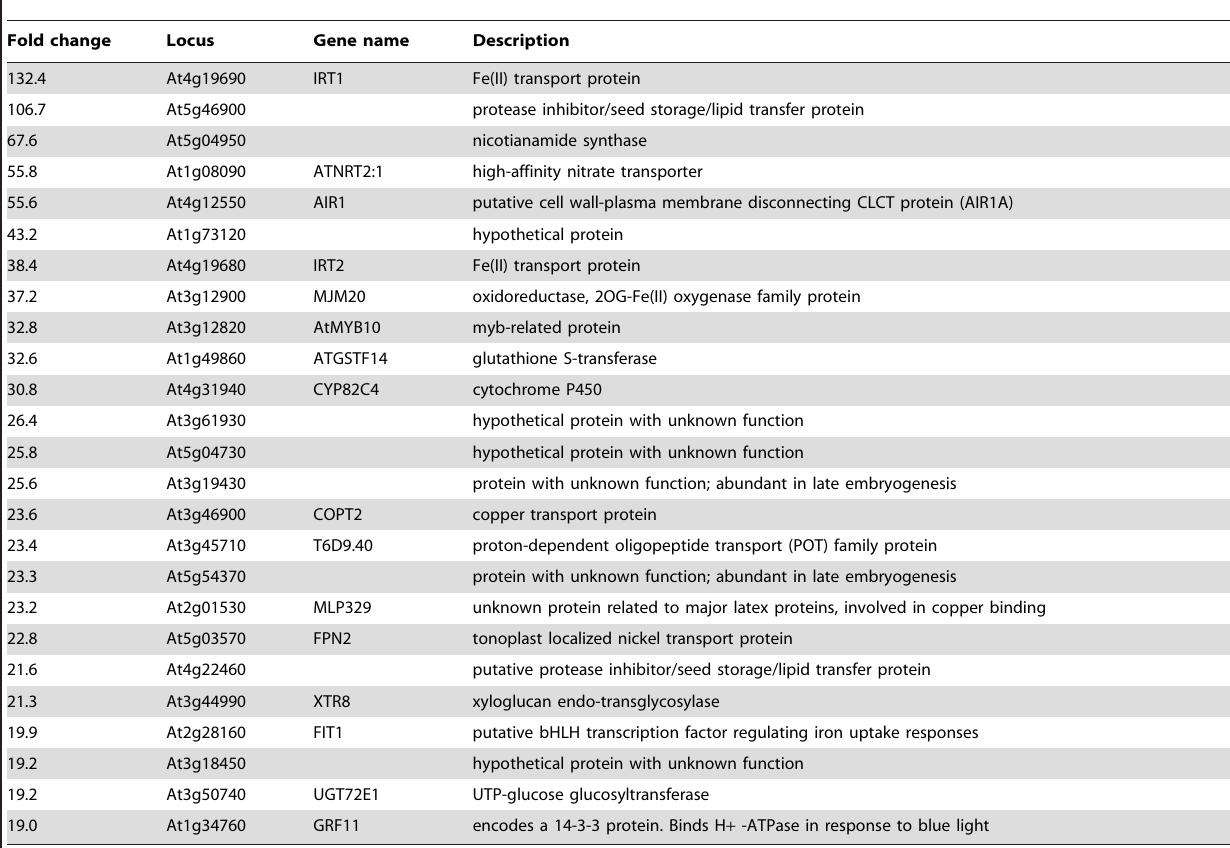
Table 3. Twenty-five genes most down-regulated in response to gold treatment.